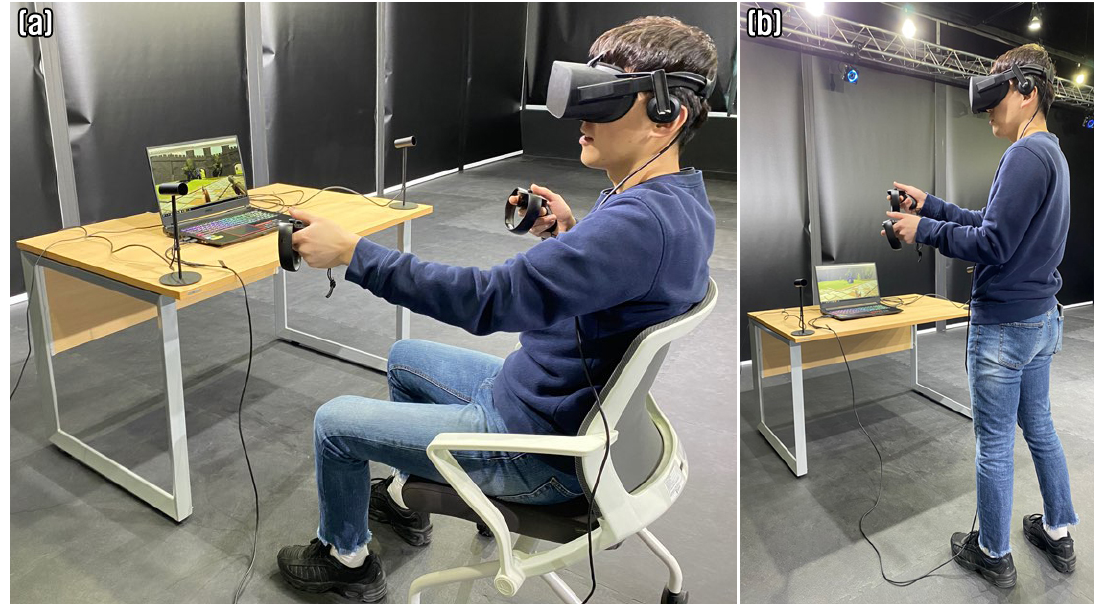
Figure 7. Immersive virtual reality experience environment: ( a ) sitting; ( b )